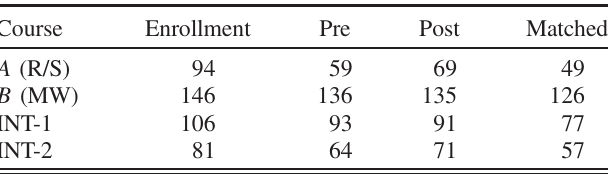
TABLE II. Total number of students enrolled at the start of the semester for each course, along with the number of pre- and postinstruction responses to the online survey, and the number of pre- and postmatched responses.